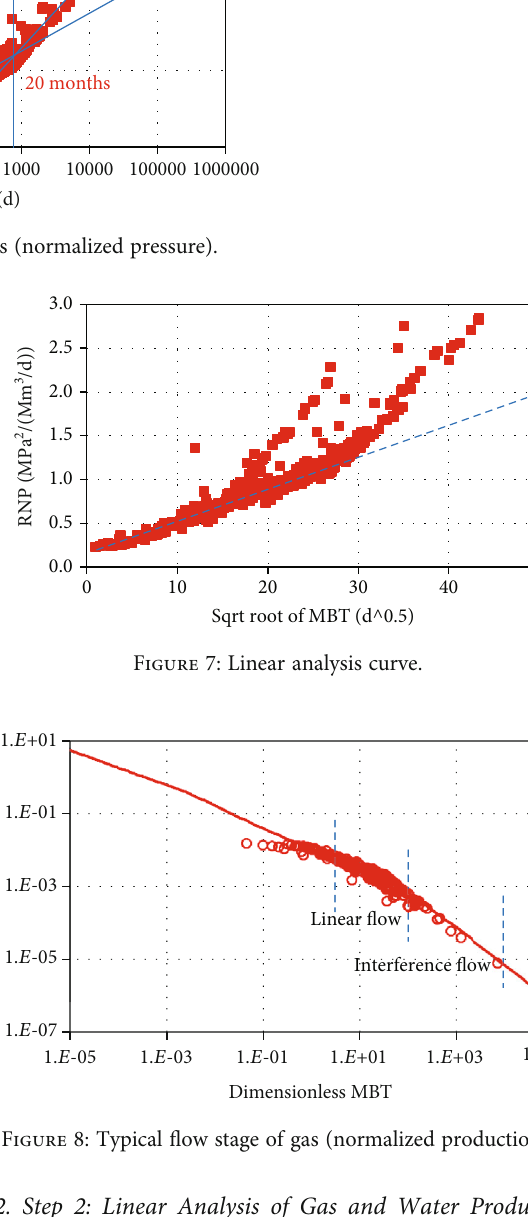
Figure 8: Typical fl ow stage of gas (normalized